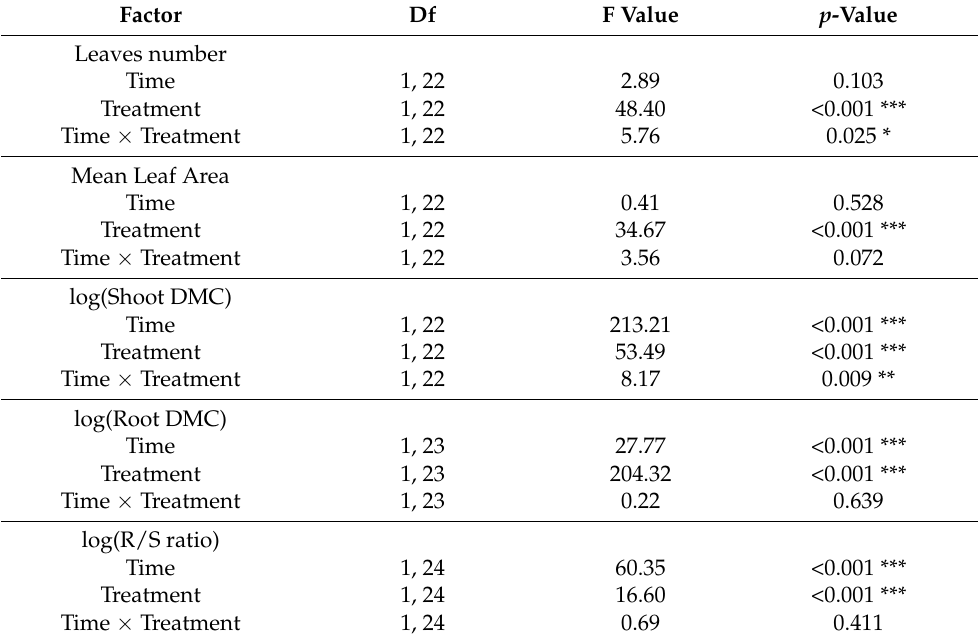
Table 1. Outcomes of the analysis of variance (two-way ANOVA) applied to leaf number, mean leaf area, shoot and root DMC, and R/S ratio in relation to drought stress (treatment), time and their